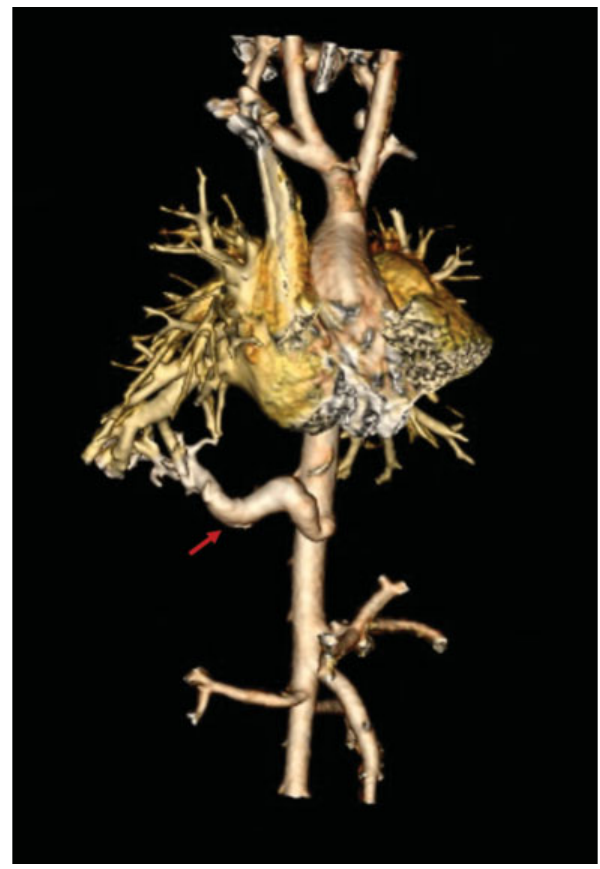
Fig. 1 Computed tomography reconstruction demonstrating the vascular anatomy of the pulmonary sequestration. Feeding artery noted by red